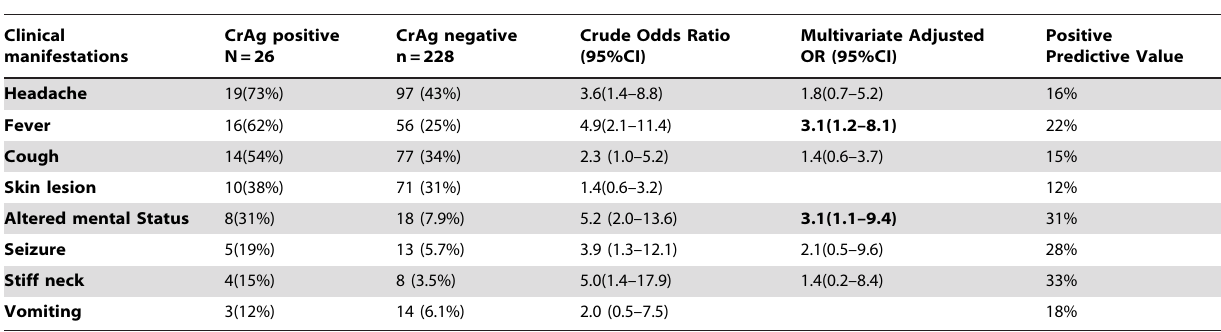
Table 4. Clinical manifestation associated with cryptococcal antigenemia.